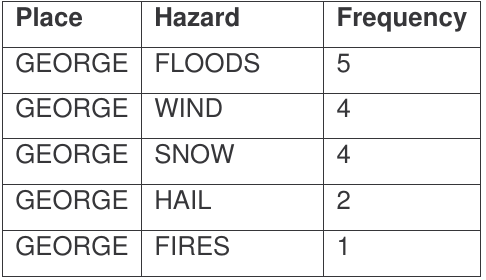
Table 2: Frequency of meteorological events in George between 1964 and 2004. Source: Caelum database,